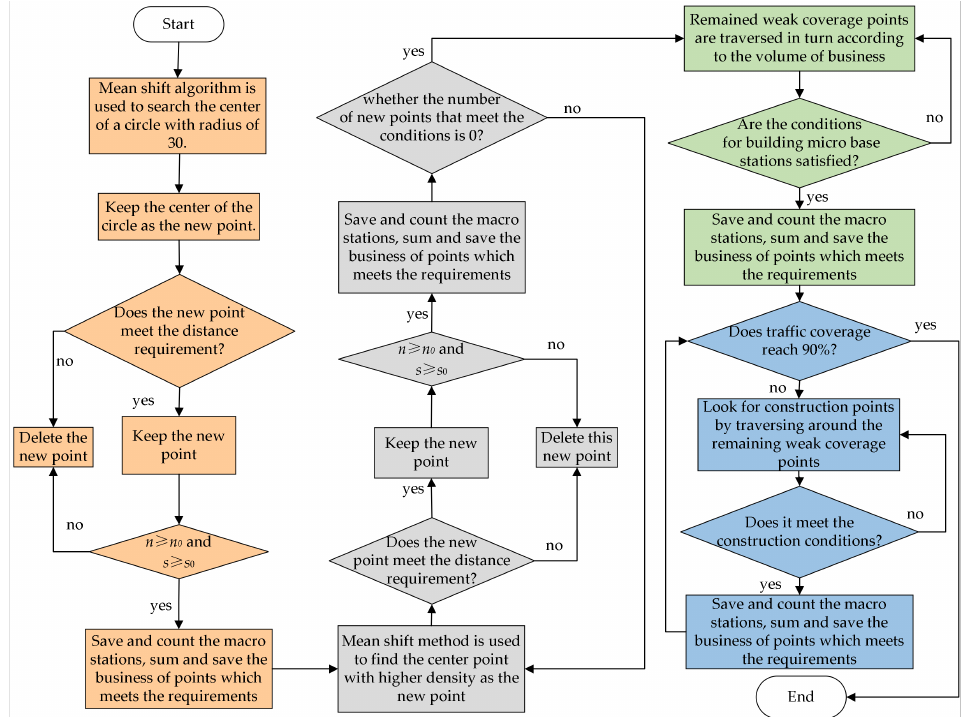
Figure 5. Flowchart of the base station site selection algorithm. Different colors correspond to the four different